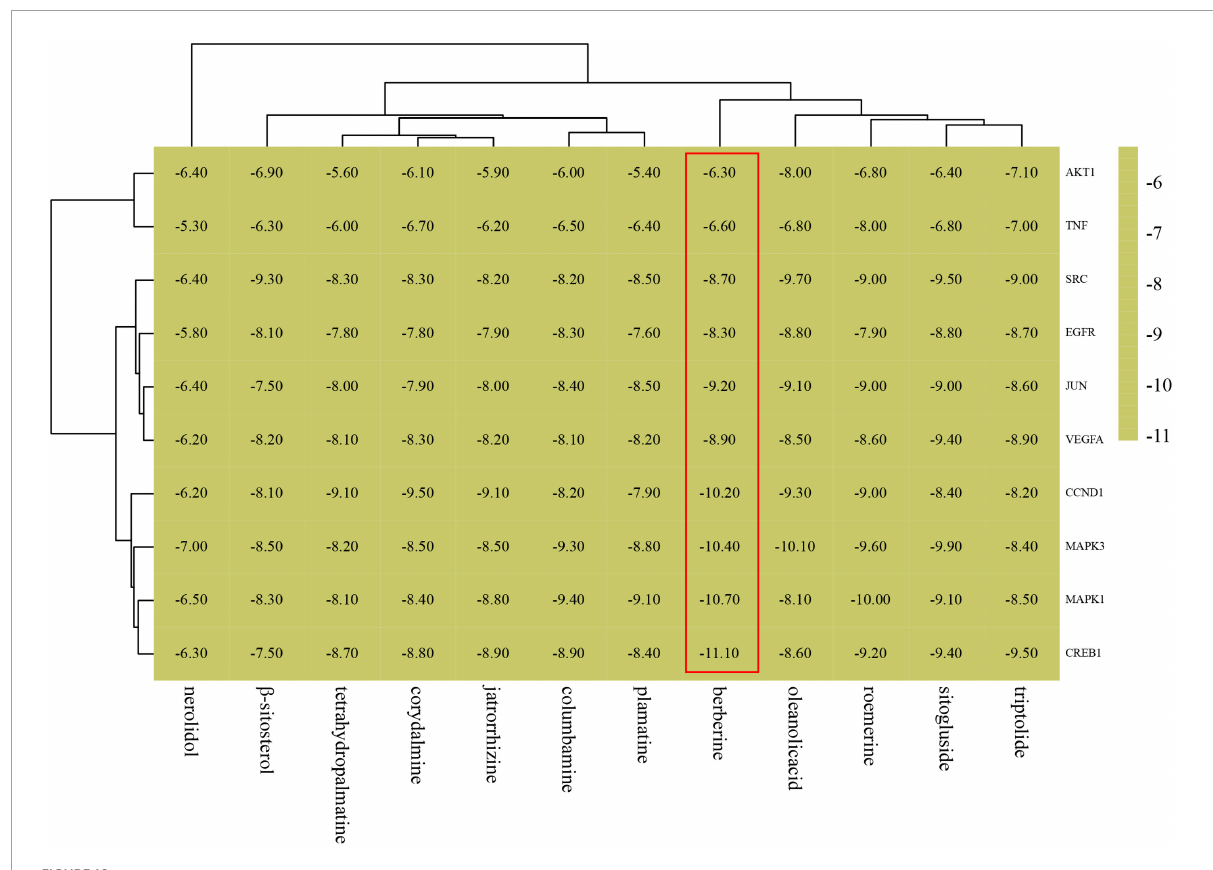
FIGURE12 Binding energy thermogram of active ingredients of FRP with target